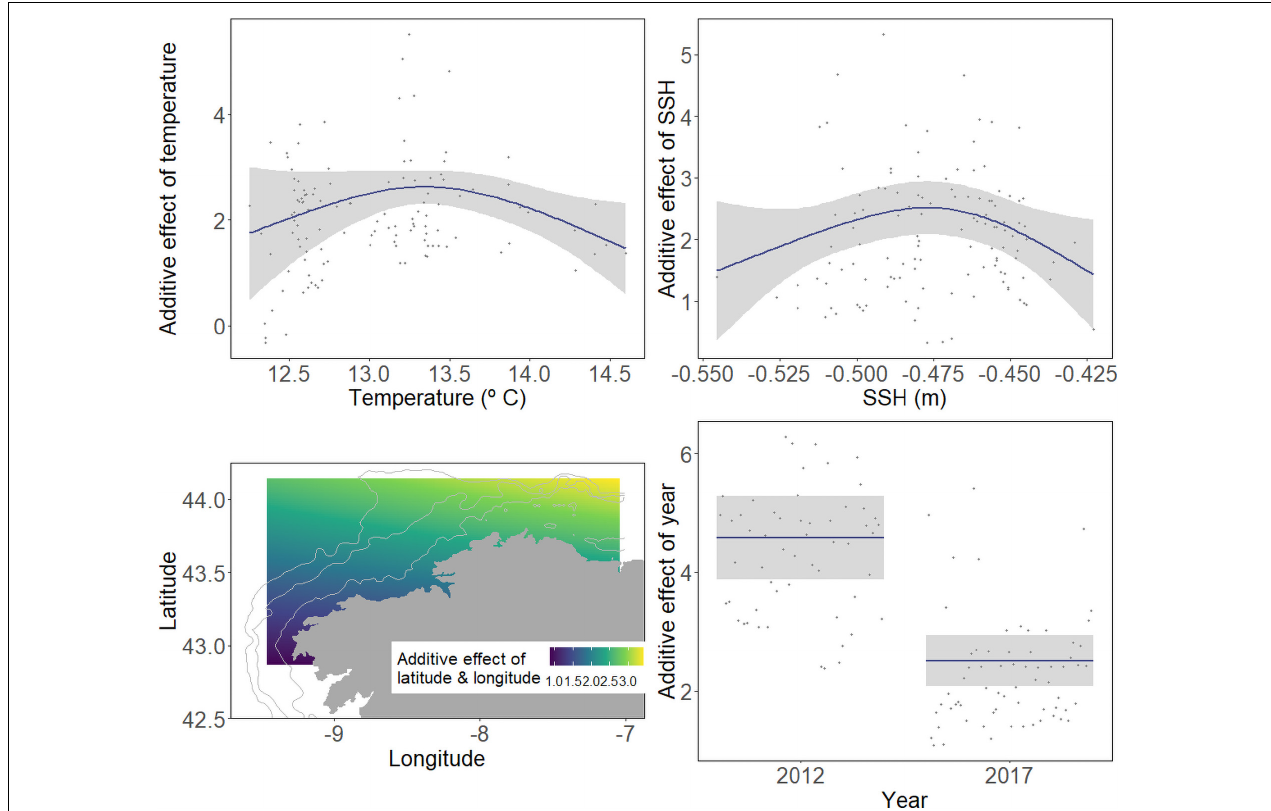
FIGURE 4 | Response plots for abiotic variables on the partial effects on the abundance of hake from final GAMs. The plot includes the additive effect of temperature at 50 m, surface height (SSH), and spatial (latitude-longitude interaction) and temporal effect (year) on the abundance of hake larvae. Solid lines denote smoothed values, and shaded areas represent 95%